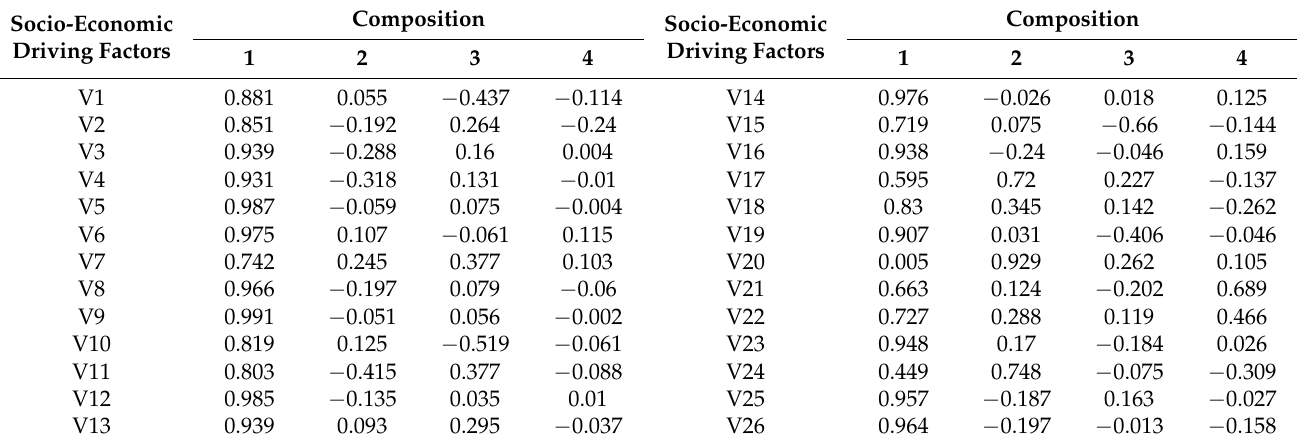
Table 4. Principal component loading